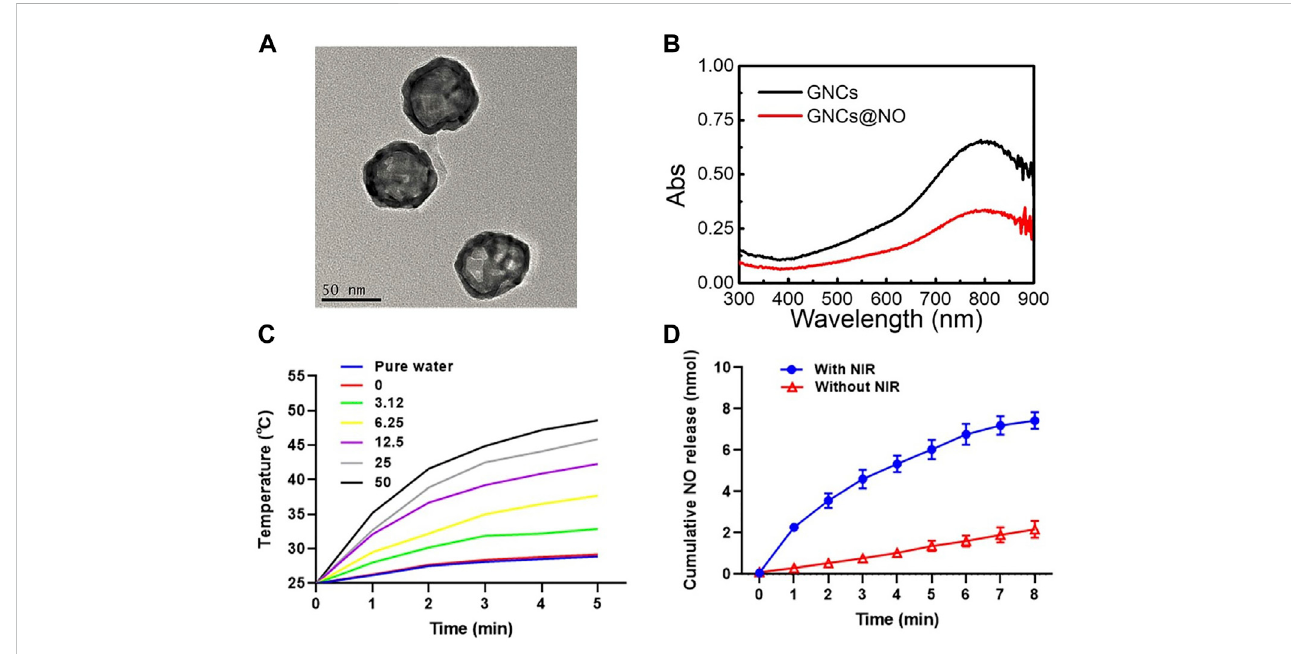
FIGURE 1 Characterization of GNCs@NO. (A) TEM image of GNCs. (B) UV-vis spectra of GNCs and GNCs@NO. (C) Temperature change curve of GNCs@NO suspensions with exposure to NIR irradiation. (D) Cumulative release of NO gas from GNCs@NO according to exposure to NIR